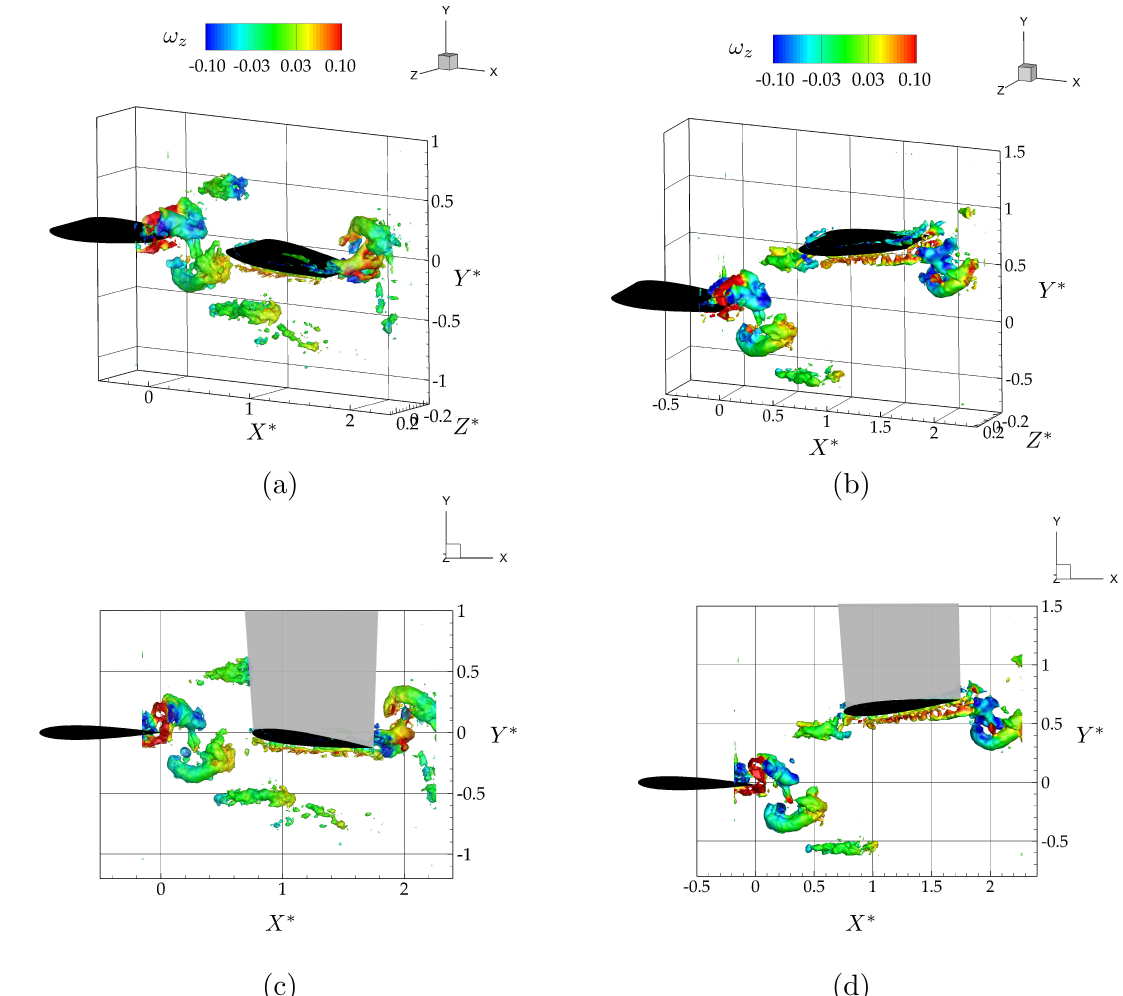
Figure 6. Isometric (top row; a , b ) and side view (bottom row; c , d ) of three-dimensional vortex structures for the in-line (left column; a , c ) and the staggered case (right column; b , d ) shown at the time instant, t ∗ = 1. The vortex structures are defined by the isosurface λ 2 = − 0.07 and are colored with corresponding values of spanwise